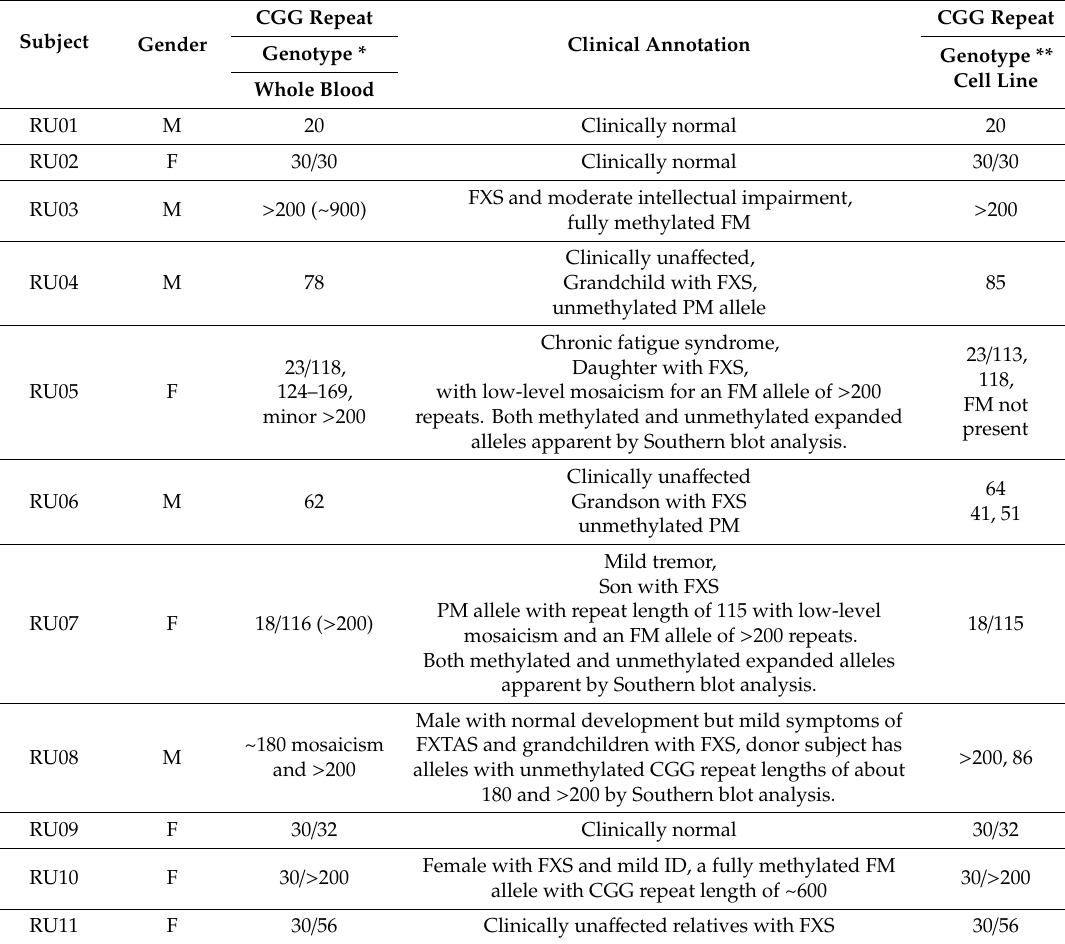
Table 4. Genetic and clinical characteristics of 11 subjects who provided blood cells for immortalized lymphoblastoid cell lines used in this